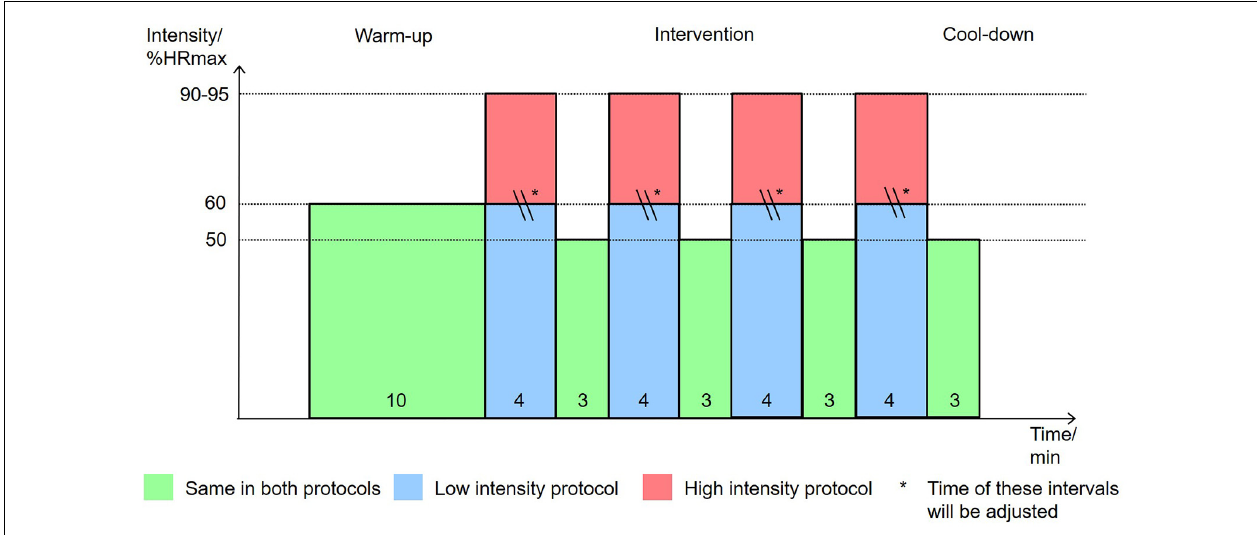
FIGURE 3 | Physical exercise intervention protocol. Note: graph shows the time in minutes each participant spends at a specific intensity in percentage of their maximum heart rate.